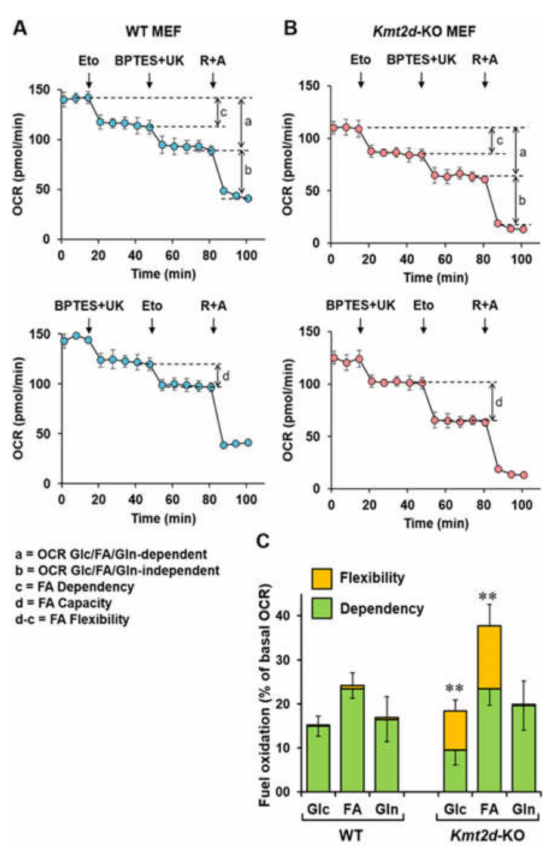
Figure 7. Mitofuel assay of Kmt2d -KO and WT MEF. Cells were assayed by the Seahorse Mito-Fuel kit as detailed in the materials and methods. ( A ) and ( B ) representative oximetric traces to assess the contribution of long-chain fatty acids (FA)s to the resting OCR. Where indicated, inhibitors of targeted pathways (see Figure 6A) were added: eto, etomoxir; BPTS + UK (5099); R + A, rotenone + antymicin A. The OCR values were utilized to extract the specific dependency, capacity, and flexibility on FA oxidation. The Glc / FA / Gln-dependent and Glc / FA / Gln-independent respiration is also shown and detailed in the legend. ( C ) Histograms showing the relative dependency and flexibility in the utilization of glucose / pyruvate (Glc), long-chain fatty acids (FAs), and glutamine (Gln) in cell respiration; the bars are mean relative values ± SEM of n = 4 independent biological replicates in triplicate; **, P <